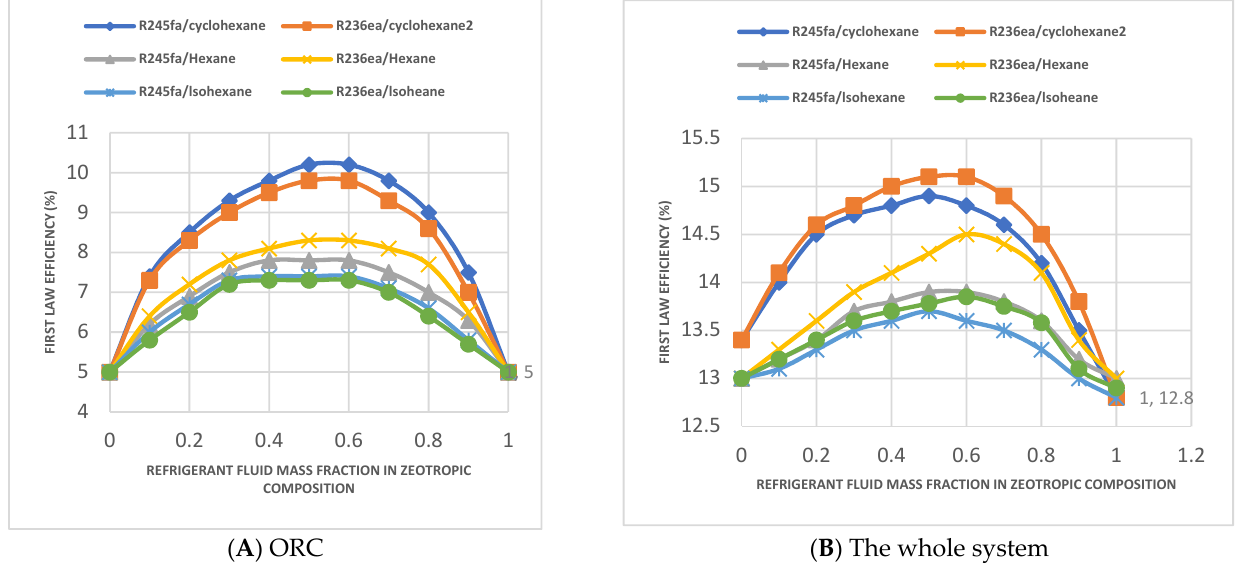
Figure 3. The efficiency of the first law of the whole system and the ORC to the mass fraction of refrigerants in the zeotropic composition.